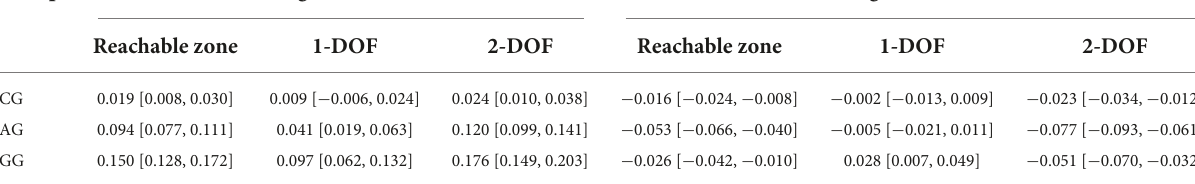
TABLE 4 Mean values and 95% confidence interval (in square brackets) of change scores for SE and UE discriminated by regions: reachable zone (1- and 2-DOF grouped), 1-DOF, and 2-DOF. Group Change score for SE Change score for